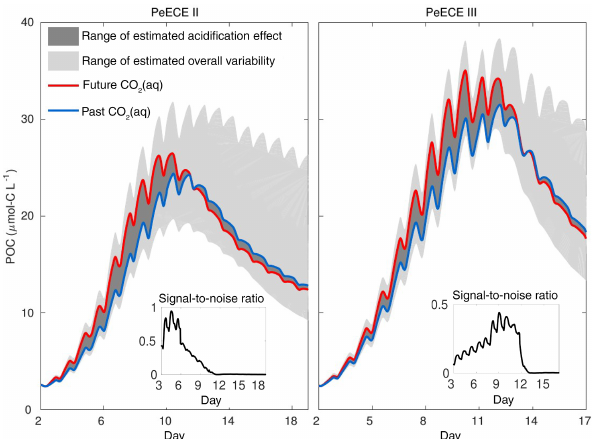
Figure 4. Reference simulations of POC for high CO 2 (red) and low CO 2 (blue) conditions bind the range of acidification effect (dark gray) according to our model projections. Light gray area shows the limits of the overall simulated POC variability, (cid:52) POC mod . Inlay graph display the signal-to-noise ration (black solid lines), i.e., the ratio between the variance of the acidification effect and the vari- ance of the overall